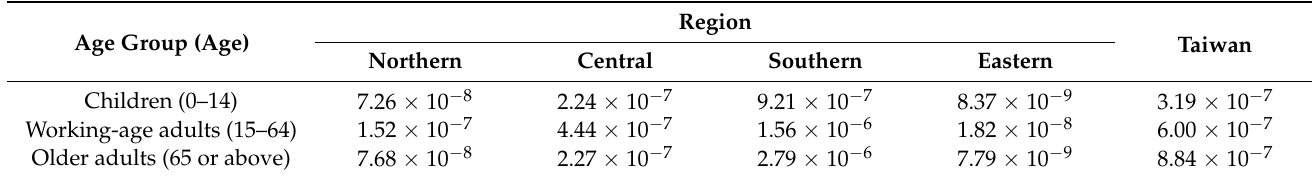
Table 3. The simulated risk of cancer for each age group in each region. Source: